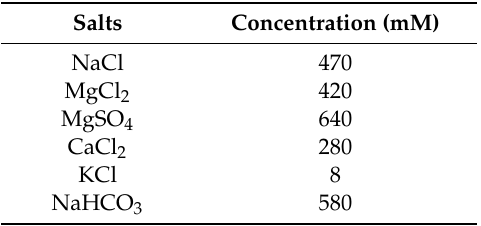
Table 1. Chemical composition of